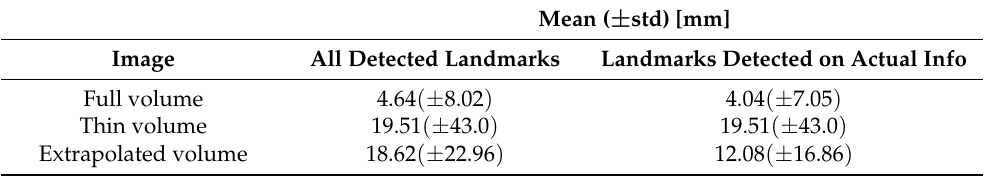
Figure 7. Detection errors. For the blue boxplots all detected landmarks were considered, while the red boxplots only take into account landmarks detected on the region containing the actual information. Table 2. Landmark detection results on the test set.